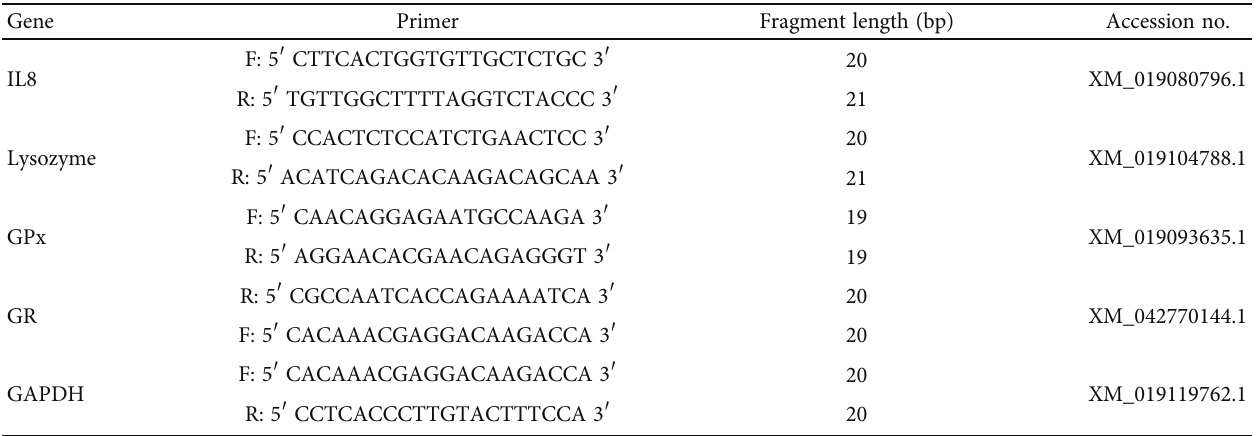
Table 2: Primers selected for the expression of the selected